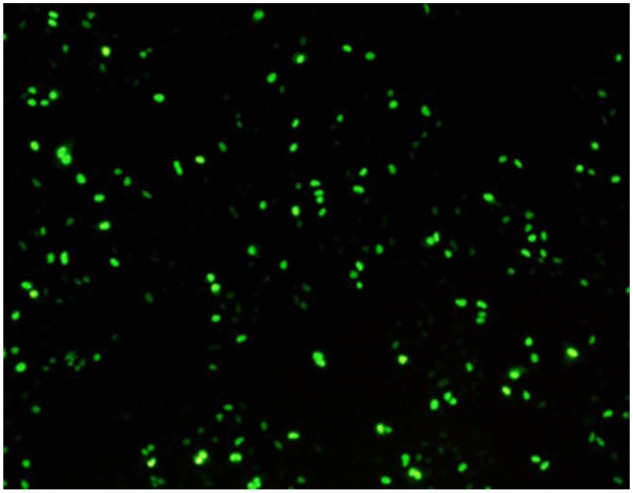
Indirect immunofluorescence analysis of A549 cells infected with CK/SD/ch confirmed infection. (Approximately 45% of the cells were infected by H9N2 at 24 hpi).